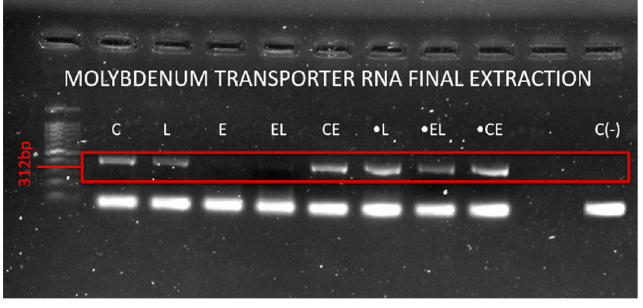
Figure 7. Electrophoresis gel for Molybdenum transporter PCR products from final soil and worm tissue RNA extraction.